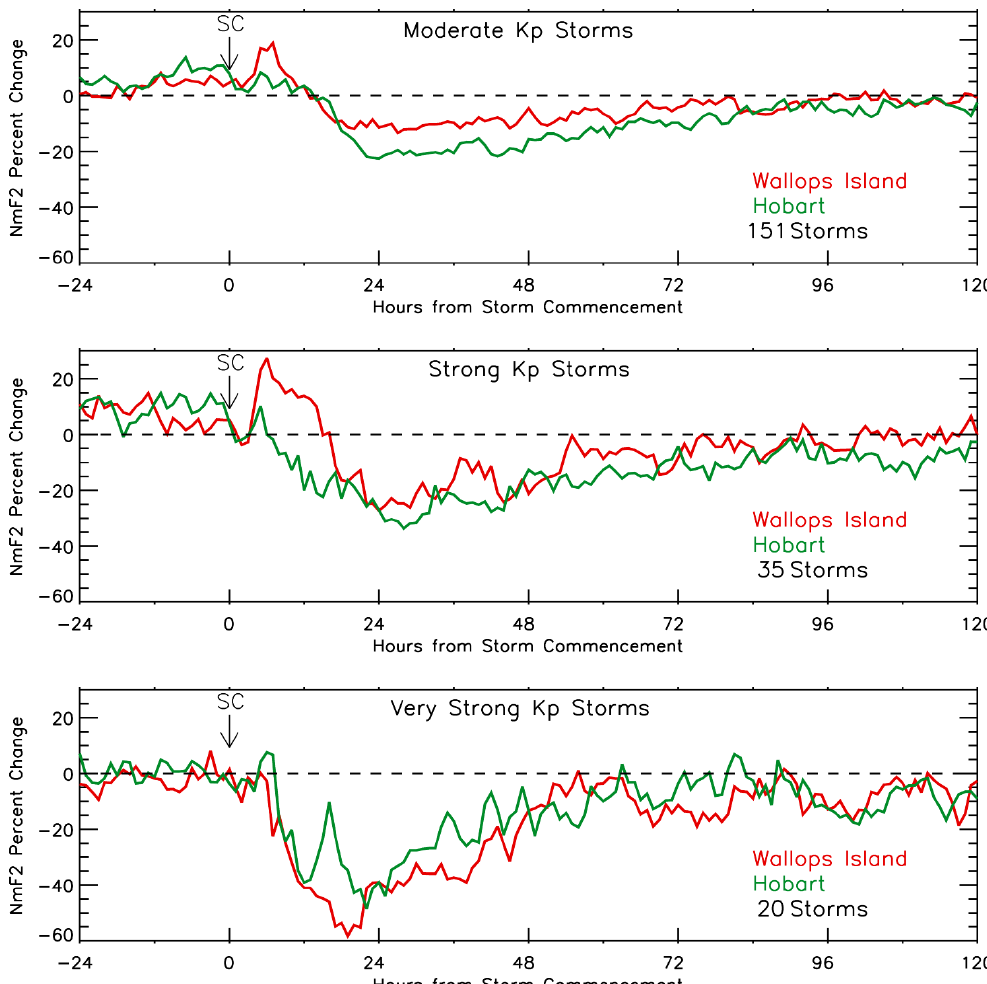
Fig. 11. The average storm-time patterns for Nm F2 for moderate, strong and very strong storms as observed at Wallops Island and